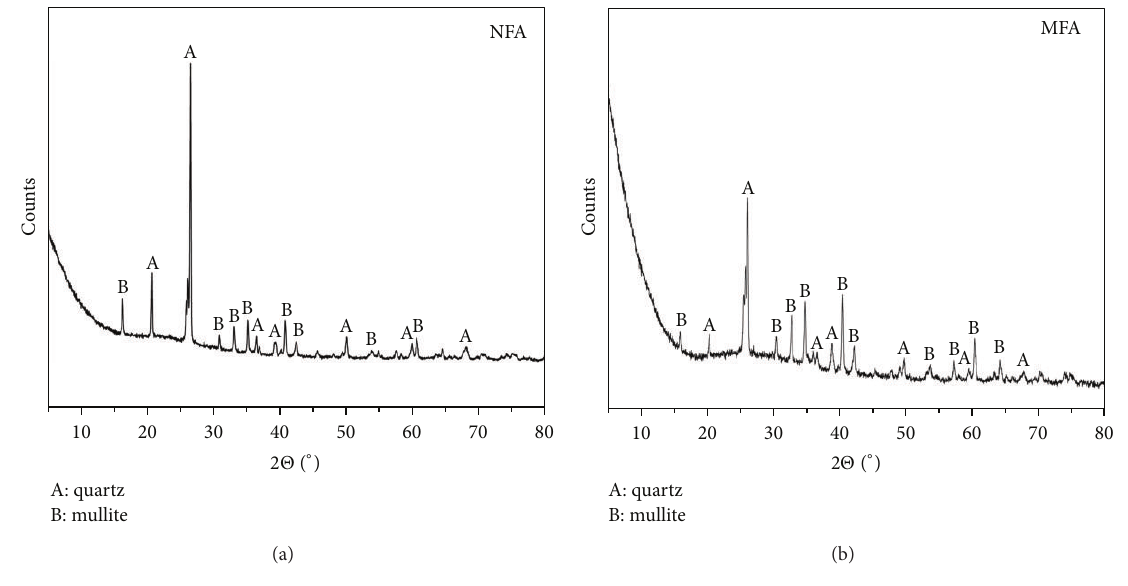
Figure 4: X-ray diffractograms of NFA and MFA.